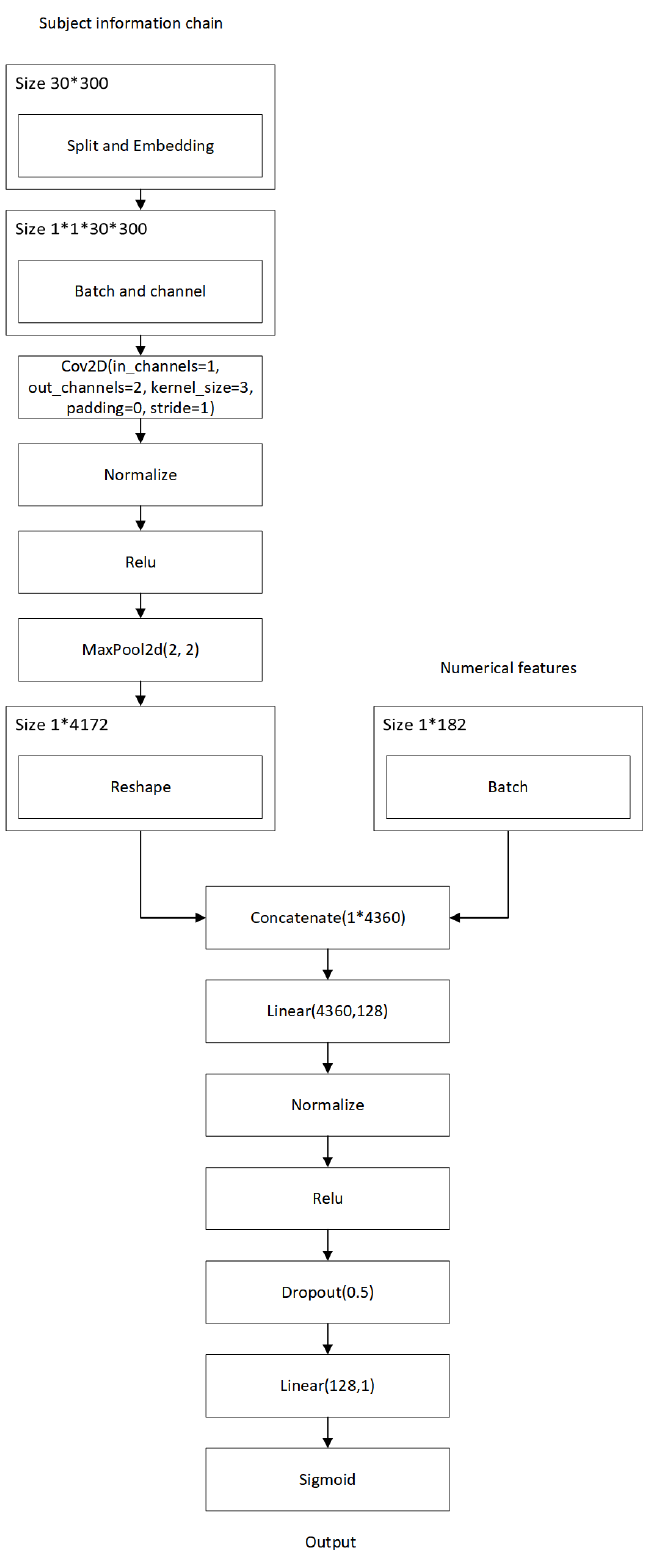
Figure A1. Details of the CNN-based